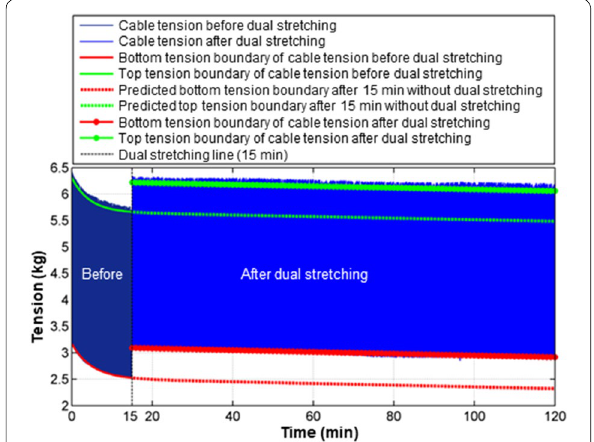
Figure 10 Tension relaxation after the dual stretching method